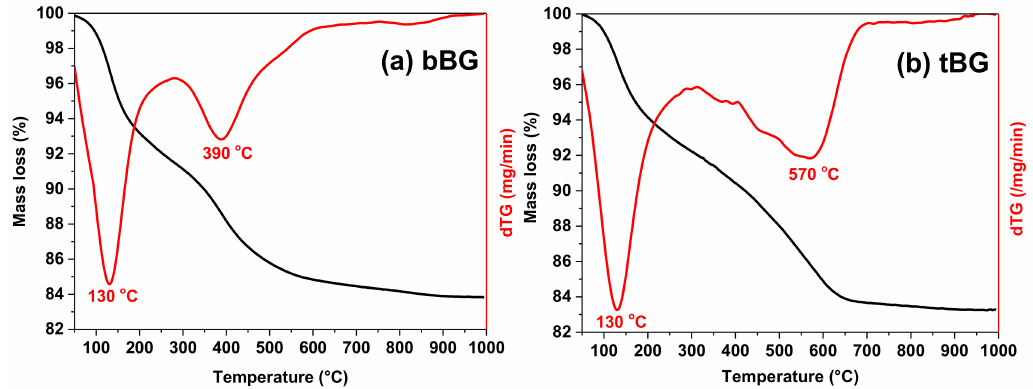
Figure 6. TGA and DTG thermograms of ( a ) bBG and ( b ) tBG.